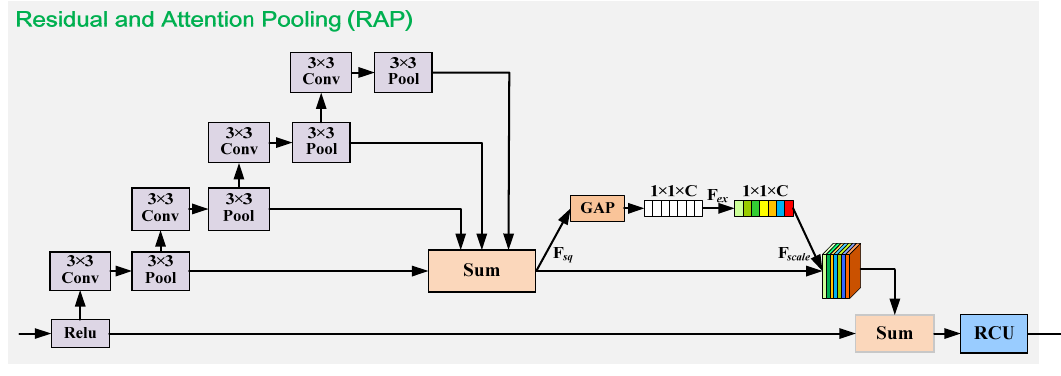
Figure 3. The Residual and Attention Pooling.